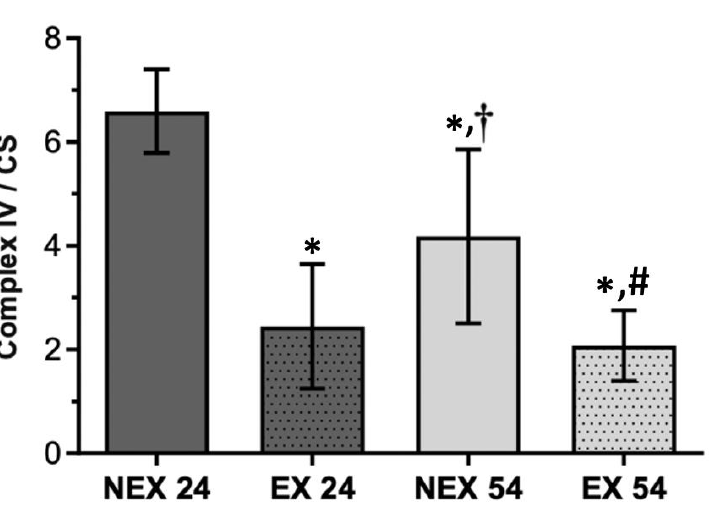
Figure 5. Effect of ageing and training in Complex IV/CS. Values are means ± SD ( n = 7), with two replicates. * p < 0.05 compared with NEX24; † p < 0.05 compared with EX24; # p < 0.05 compared with NEX54; NEX24 (non-exercising young, sacrifice at 24 weeks of training), EX24 (exercise young, sacrifice at 24 weeks of training), NEX54 (non-exercising middle-age, sacrifice at 54 weeks of training), EX54 (exercise middle-age, sacrifice at 54 weeks of training).